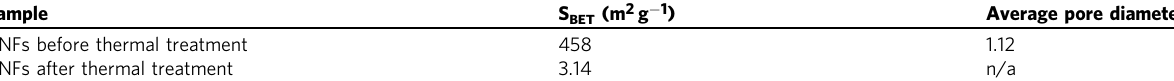
Table 1 Surface area and pore volume measurements of CNFs before and after thermal treatment.